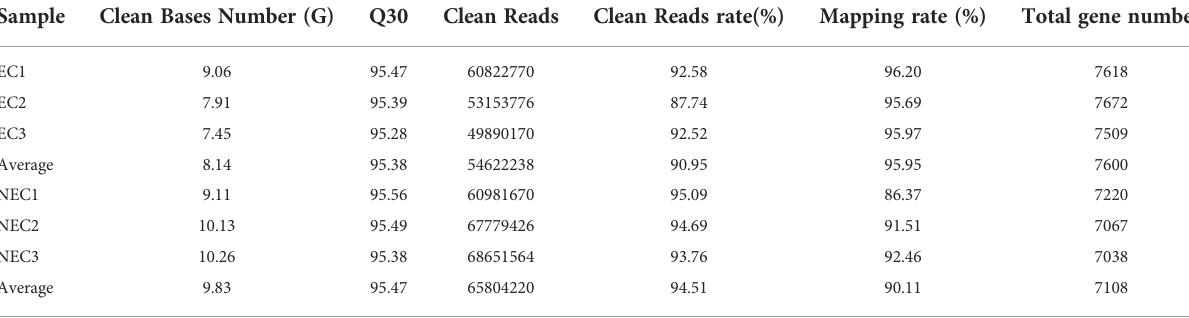
TABLE 1 Transcriptome sequencing results for ECs and NECs of G. lemaneiformis .